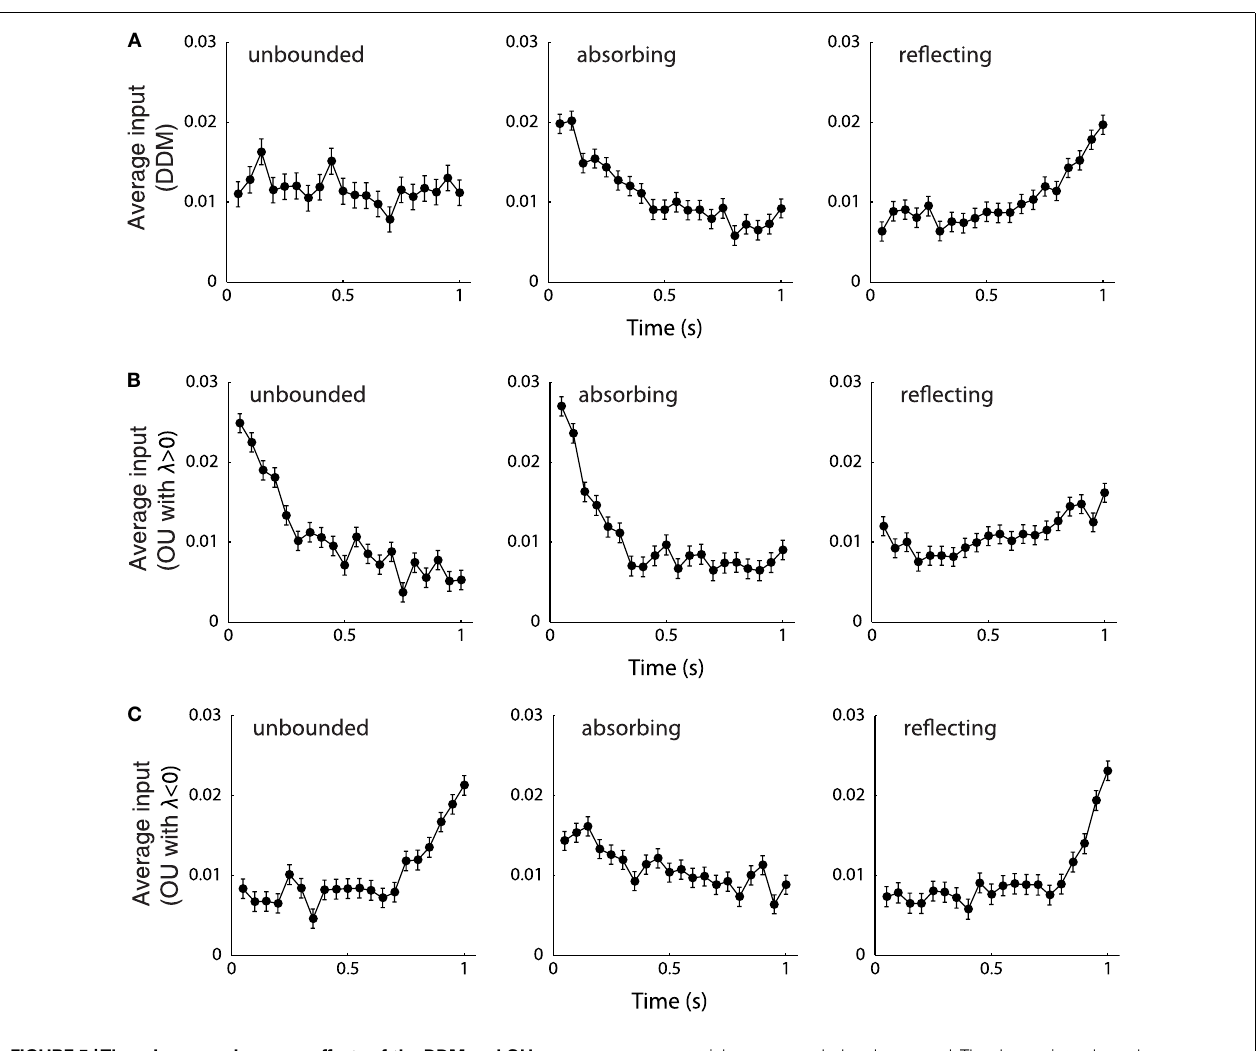
correct trials was recorded and averaged.The data points show the FIGURE 5 |The primacy and recency effects of the DDM and OU means and standard errors of the sensory evidence at every time step. model. (A) The bounded and unbounded DDM. (B) The bounded and For µ > 0, a larger averaged input indicates that the sensory evidence at unbounded OU models with λ > 0. (C) The bounded and unbounded OU model with λ < 0. All the models were simulated with µ = 0.71s − 1 , that time point has, on average, a larger influence on the final choice, and σ = 1s − 1 , b = 0.47, and T = 1s.The growth-decay parameter of the OU a smaller averaged input indicates that the choice depends to a lesser c extent on the evidence at that time. Figure modified from Zhang and models was set to λ = 5.5 (B) and λ =− 5.5 (C) . In each panel, the model Bogacz was simulated for 10,000 trials, and the sensory evidence from all